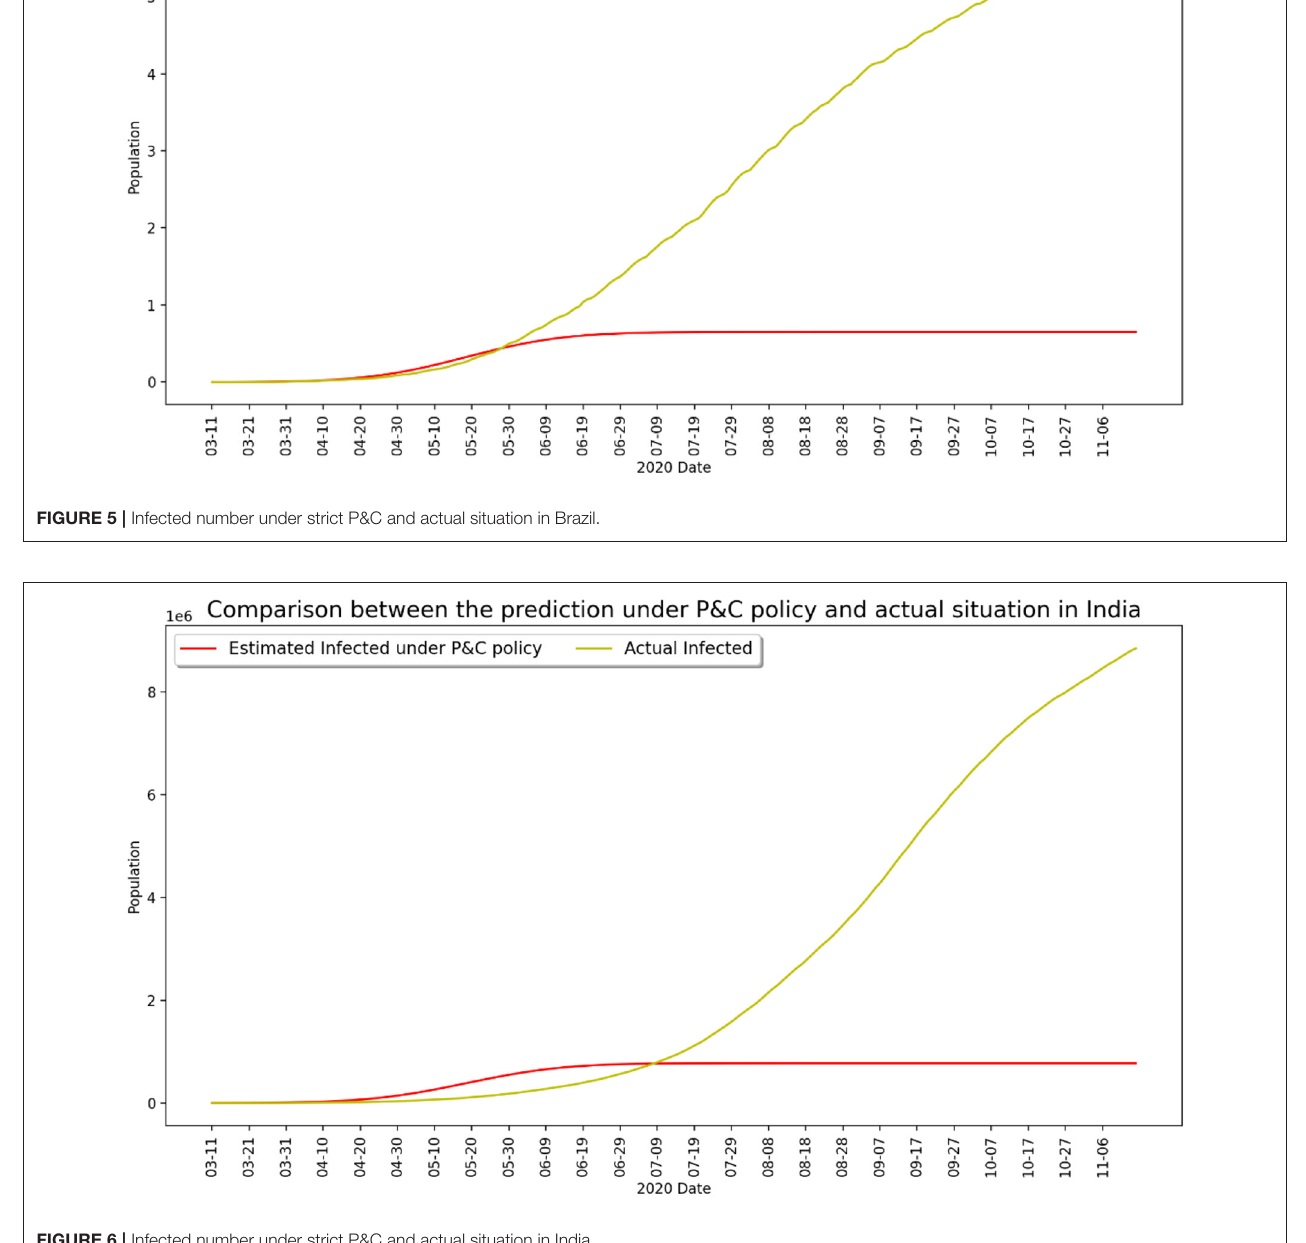
FIGURE 6 | Infected number under strict P&C and actual situation in